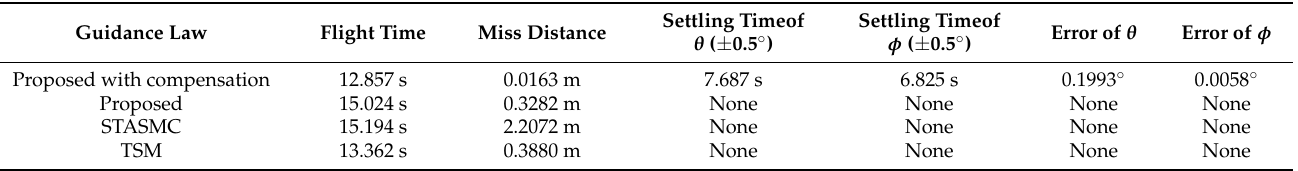
Table 5. Simulation results of scenario